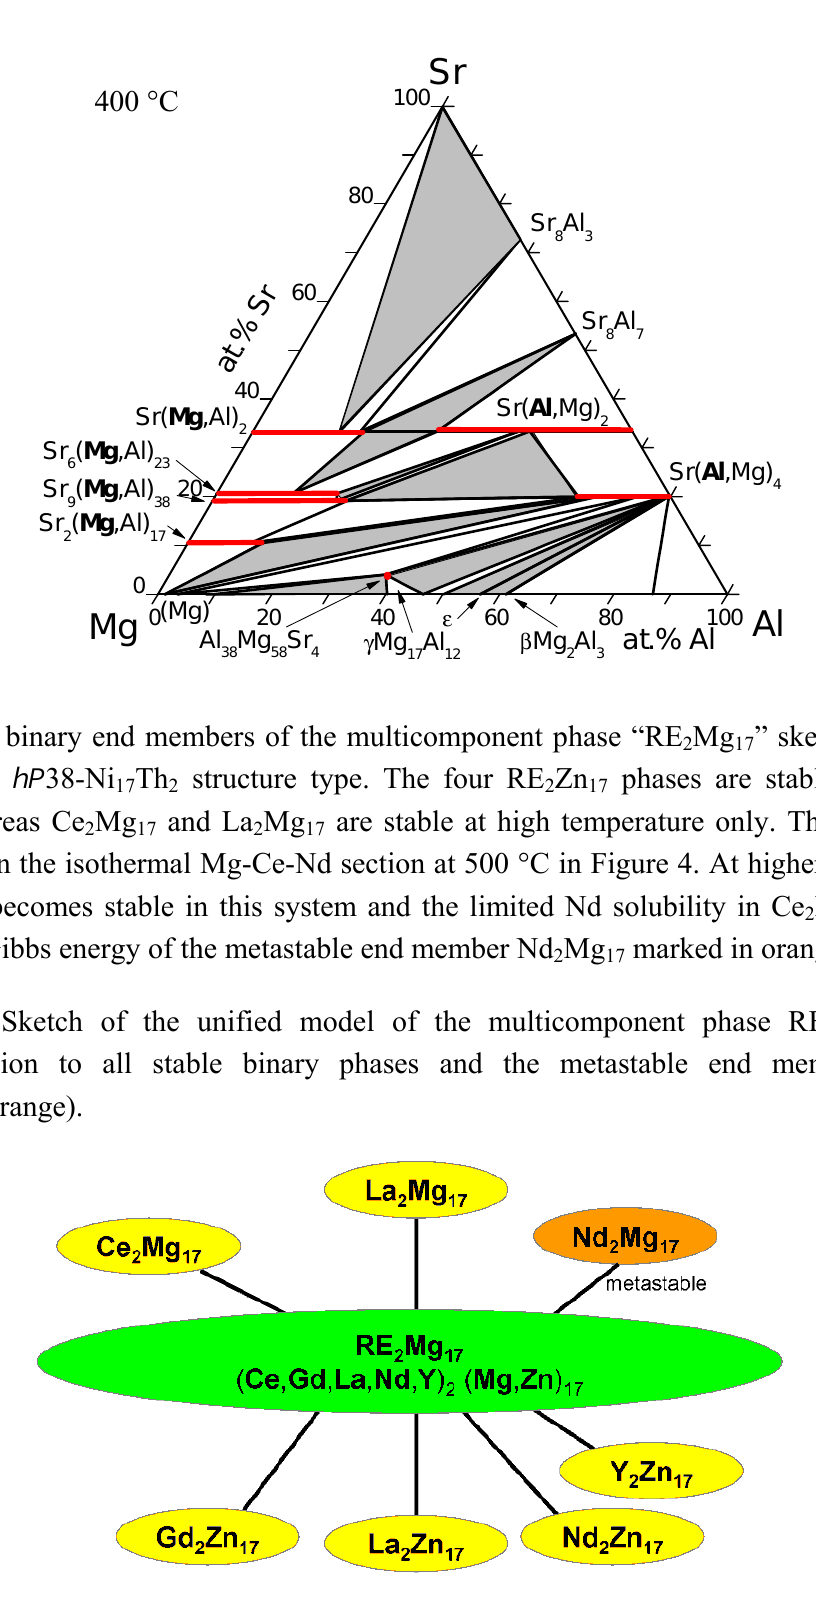
Figure 7. Calculated isothermal Mg-Al-Sr phase diagram at 400 °C highlighting six intermetallic solution phases with limited ternary solubility plus one ternary stoichiometric phase [26].